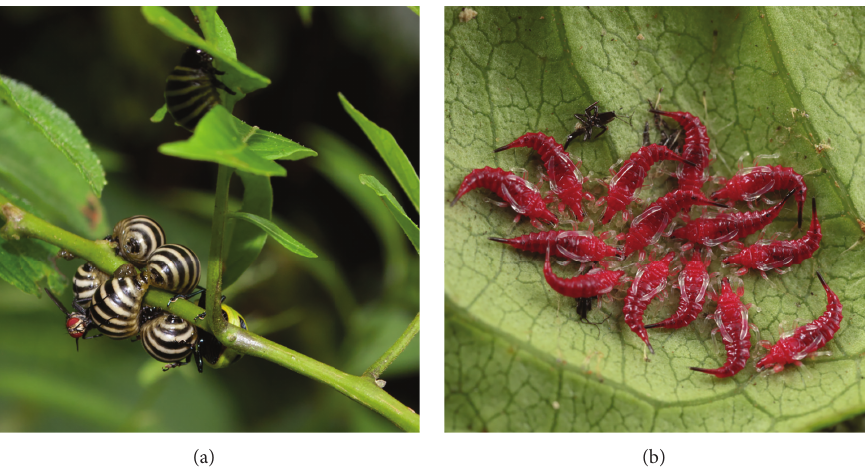
Figure 5: (a) Larvae of Proseicela spectabilis Baly (Chrysomelidae: Chrysomelinae) at rest encircling the stem of their host plant with tachinid flyatthebottomleftoftheclusterandtheadultfemalebeetleontheoppositeside.PhotographtakeninReventador,NapoProvince,Ecuador,© G. Dury. (b) Circularresting positionin Panamanian thrips( Anactinothrips sp.) on Maripa panamensis Hemsl. (Convolvulaceae). Photograph taken 24 April 2013, on Cerro Campana, Panama. © G.